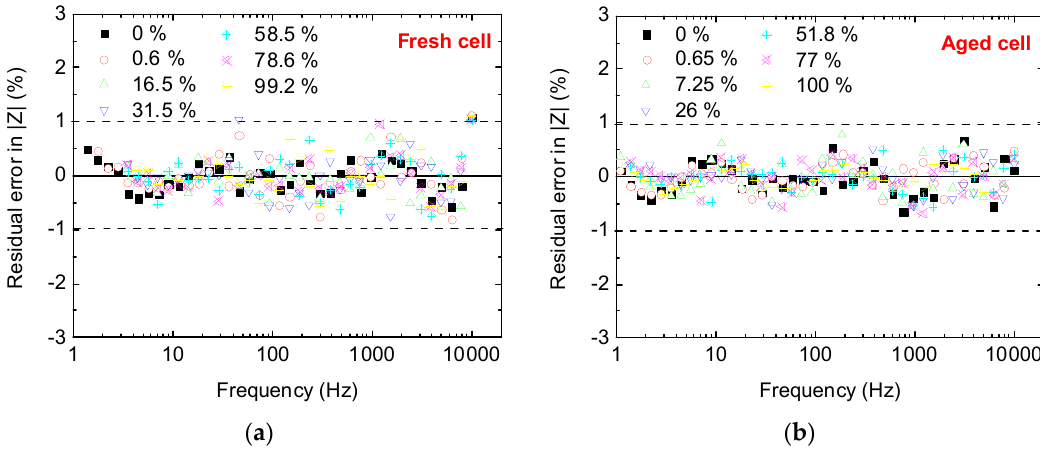
Figure A4. Residual errors for ( a ) a fresh full-cell and ( b ) an aged full-cell at various SoCs. Residual errors are obtained as the difference between the experimental values and the estimated ones for each frequency. Batteries 2018 , 4 , x FOR PEER REVIEW